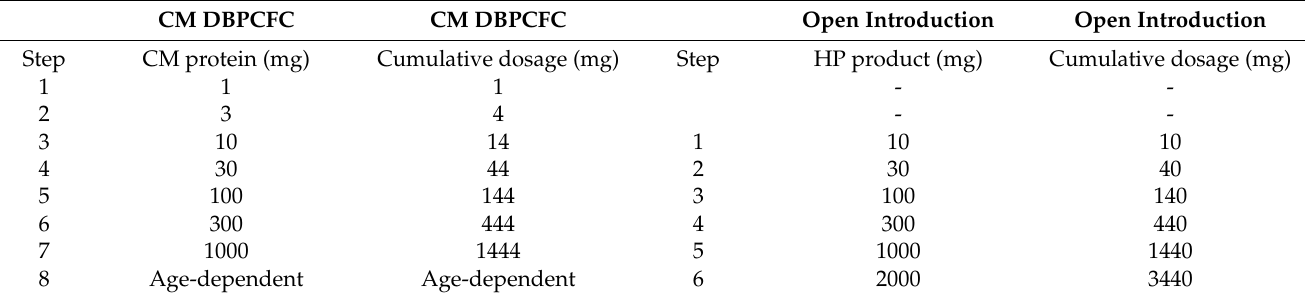
Table 1. Dosages in double-blind, placebo-controlled CM challenge and HP product introduction, as well as cumulative